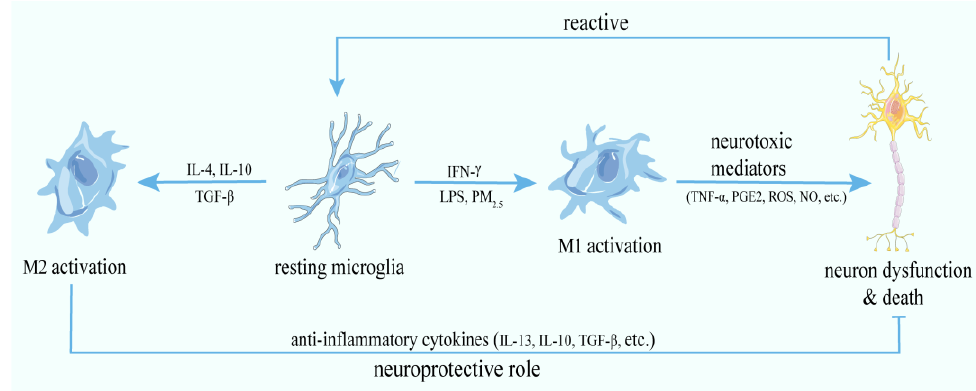
Figure 1. M1/M2 phenotypes and functions of microglia. The resting microglia can be activated by toxic mediators, such as IFN- γ , LPS, and PM 2.5 , and display a M1 phenotype. In this condition, microglia induce neurotoxicity via release of neurotoxic mediators (TNF- α , PGE2, ROS, NO, etc.). The factors secreted by the dead or damaged neurons in turn exacerbate the chronic activation of microglia. Besides the M1 phenotype, in combination with IL-4, IL-10, and TGF- β , microglia could be induced into the M2 phenotype, which plays a neuroprotective role through the generation and release of anti-inflammatory cytokines (IL-13, IL-10, TGF- β , etc.). From the above, activated microglia show a broad spectrum of phenotypes